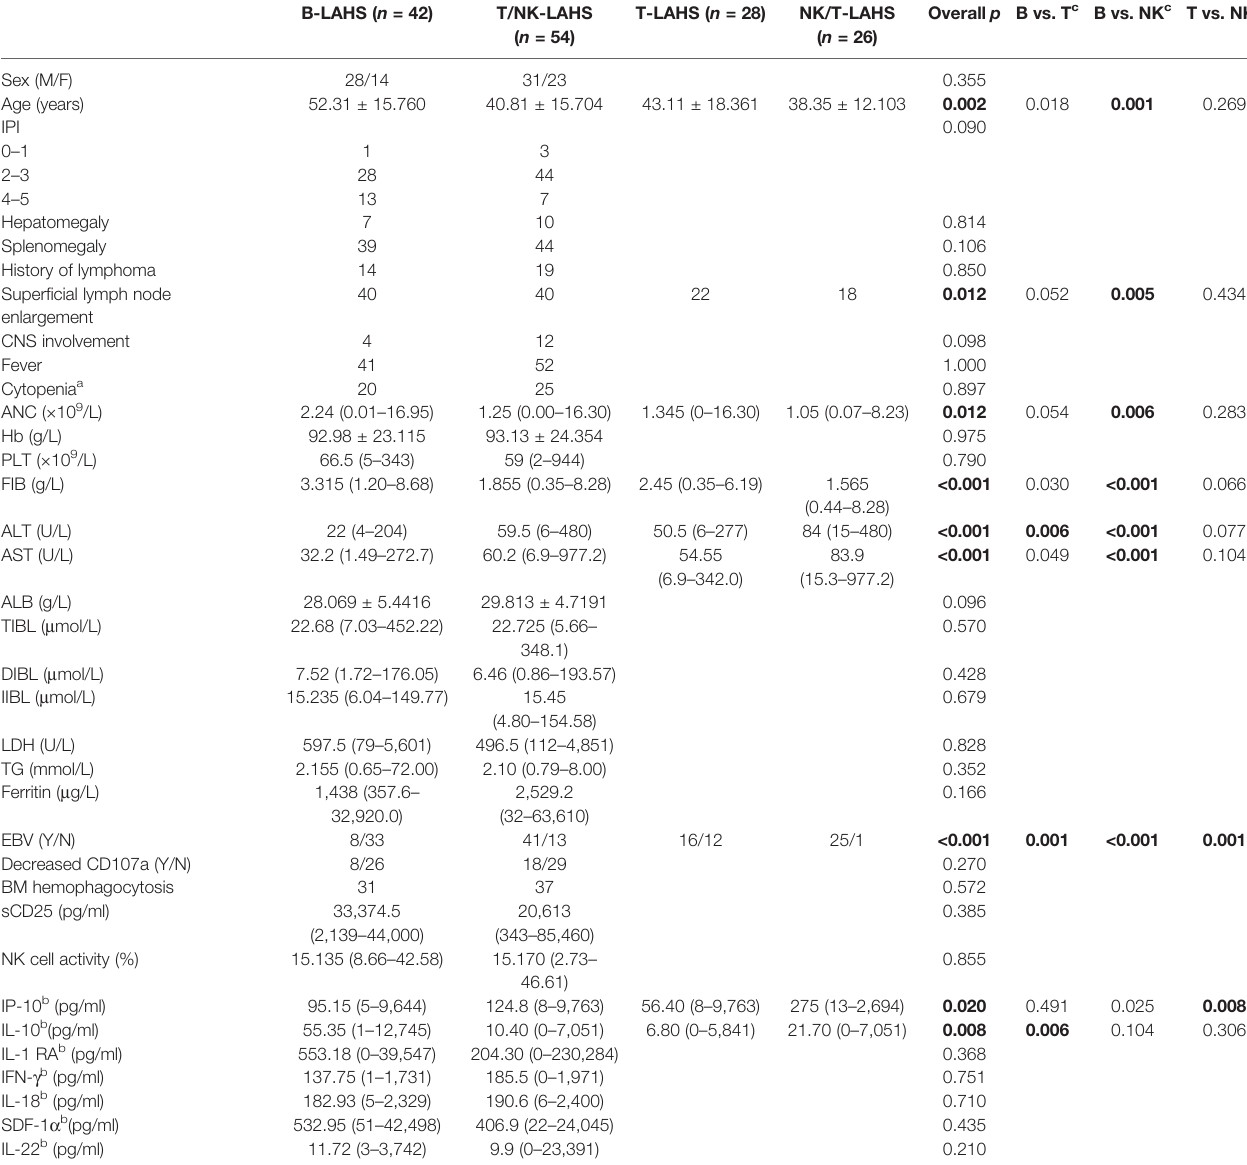
TABLE 2 | Clinical characteristics of patients with B-LAHS and